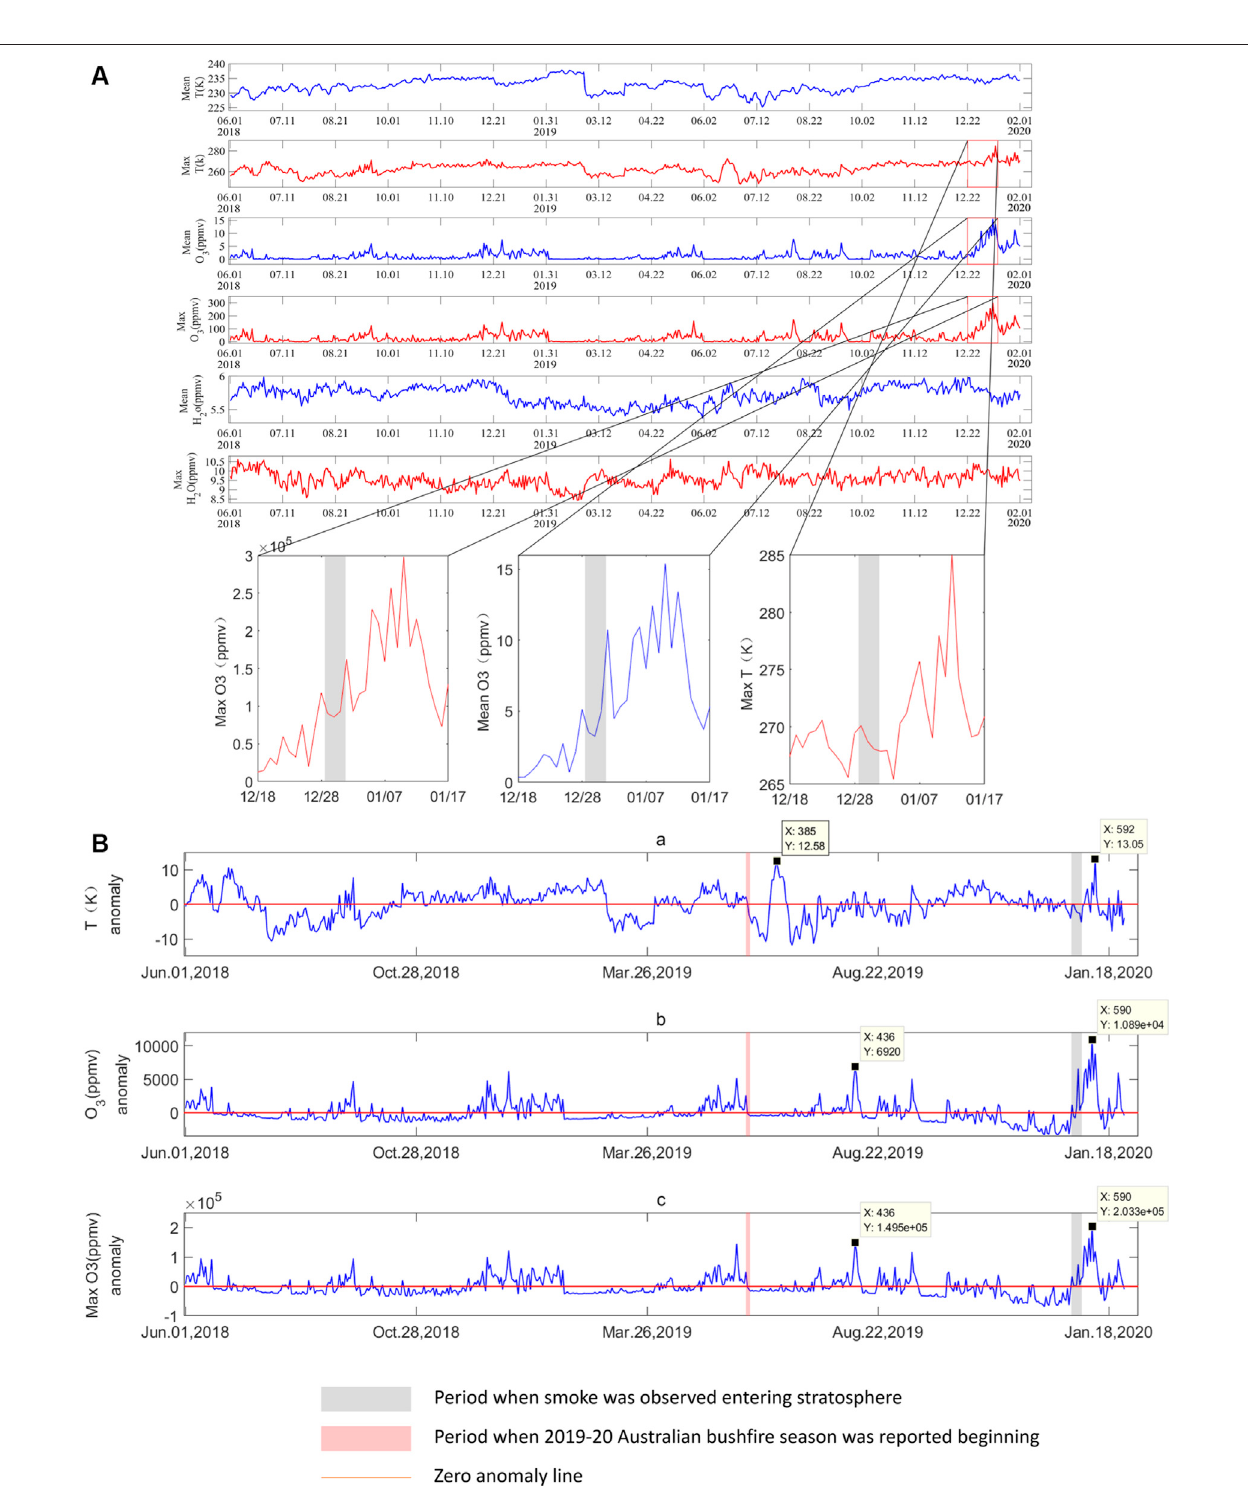
FIGURE 5 | (A) Stratospheric (10 – 50 km) atmospheric components (temperature, ozone, and water vapour) over Australia (10 ° – 42 ° S, 113 ° – 153 ° E) from June 1, 2018, to January 31, 2020 (The blue line represents the daily average value of the atmospheric component, and the red line represents the daily maximum value of the atmospheric component.) The period from December 29, 2019, to January 1, 2020, is fi lled with light grey in the magni fi ed image of the period corresponding to the